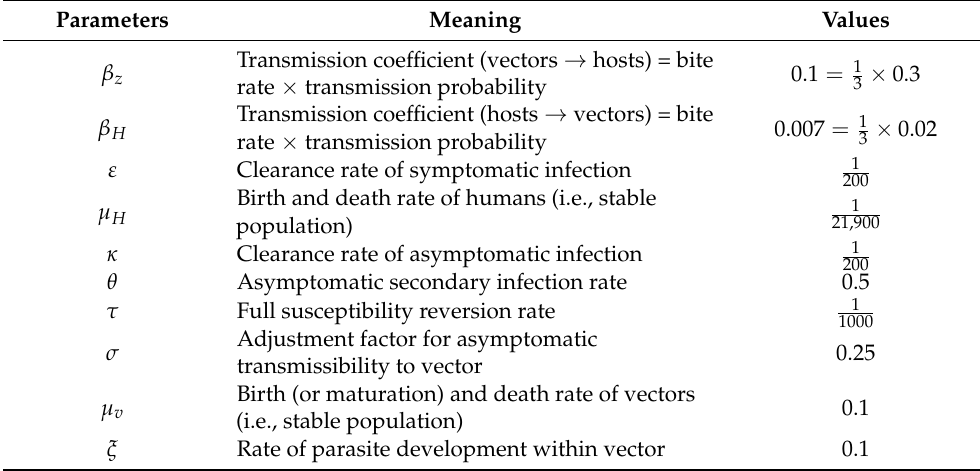
Table 1. List of parameters and functions